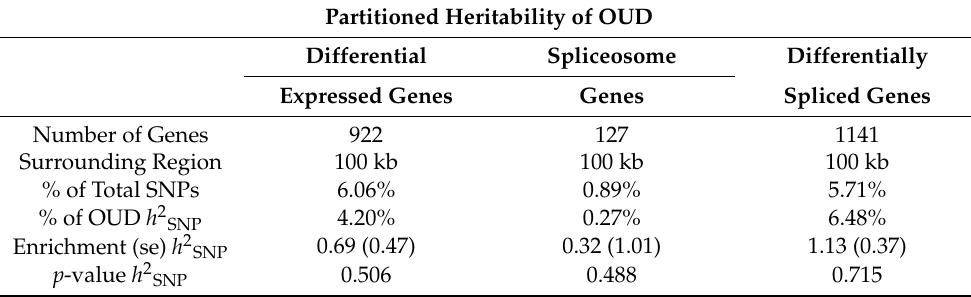
Table 2. Genetic analyses of OUD using genes identified from OUD brain data. Partitioned Heritability of OUD Differential Spliceosome Differentially Expressed Genes Genes Spliced Genes Number of Genes 922 1141 Surrounding